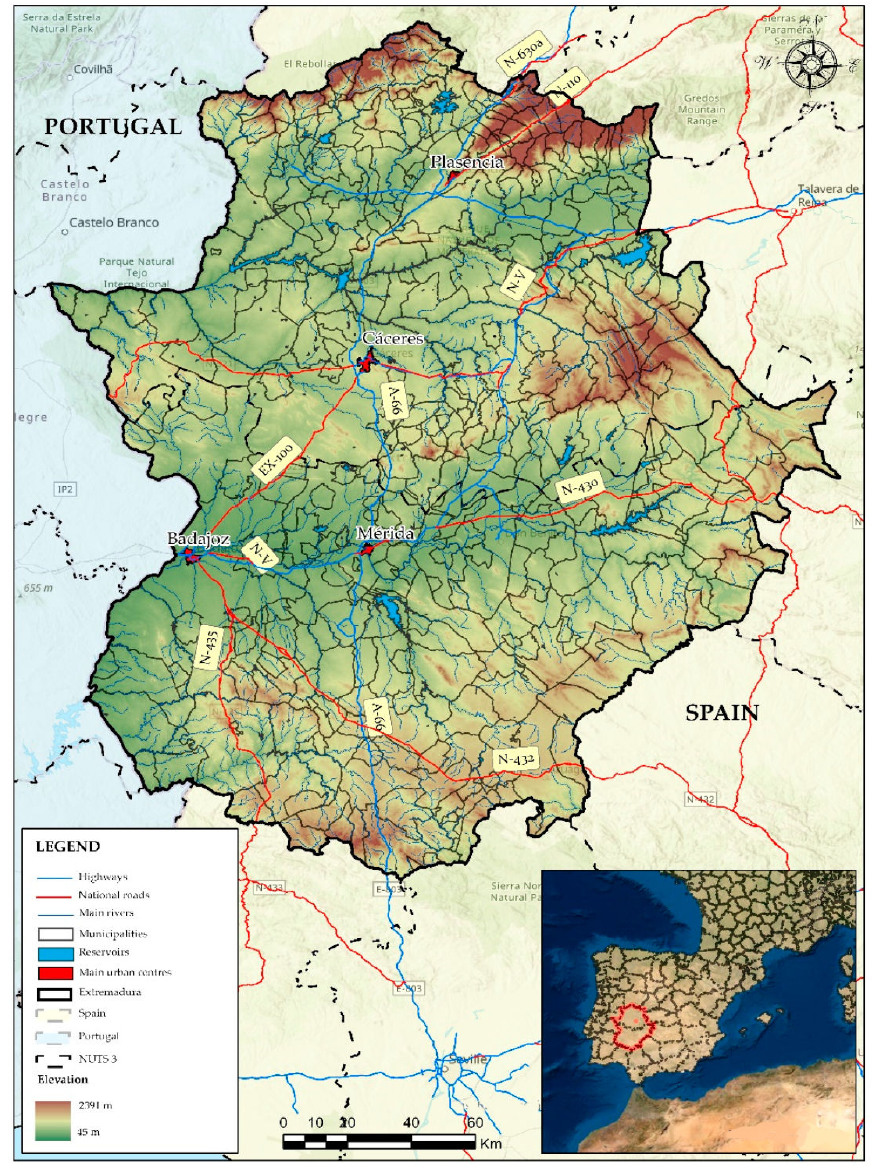
Figure 1. Study area: Extremadura (Spain). Source: